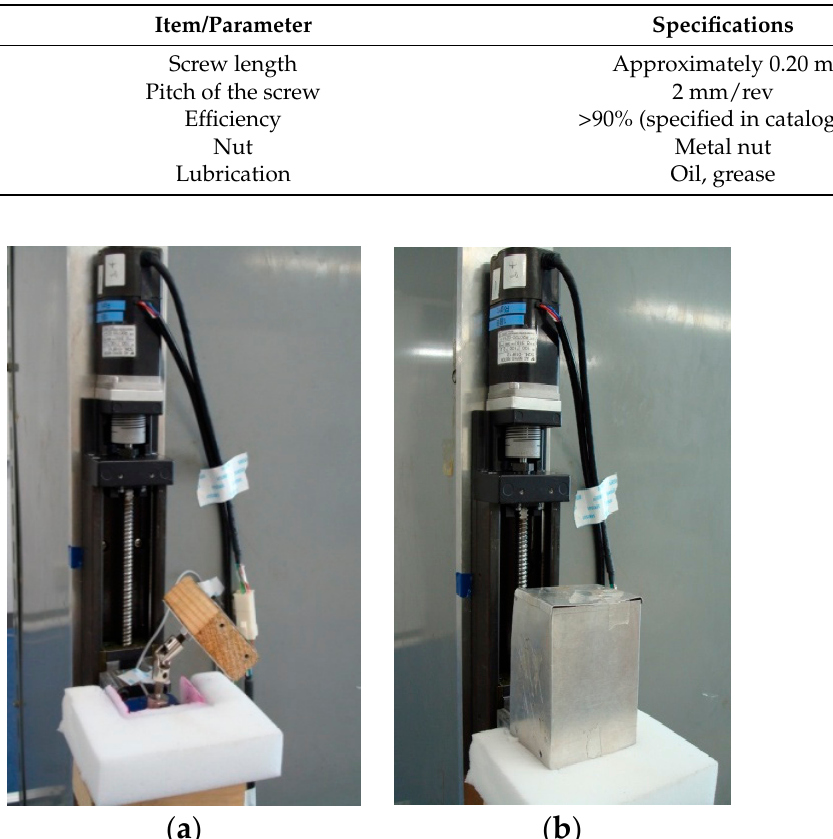
Table 2. Specifications of the ball screw system.